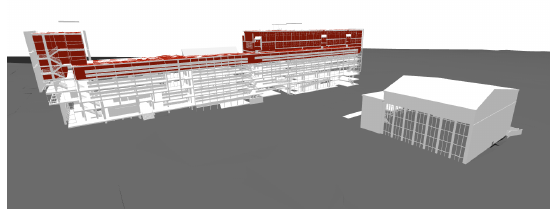
Figure 9. Visualisation of above query via QGIS. Query results include all rooms in storey 4 and 5 painted in